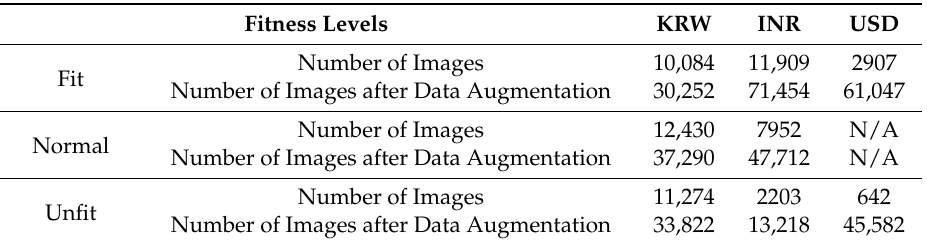
Table 3. Number of banknote images in each national currency database.